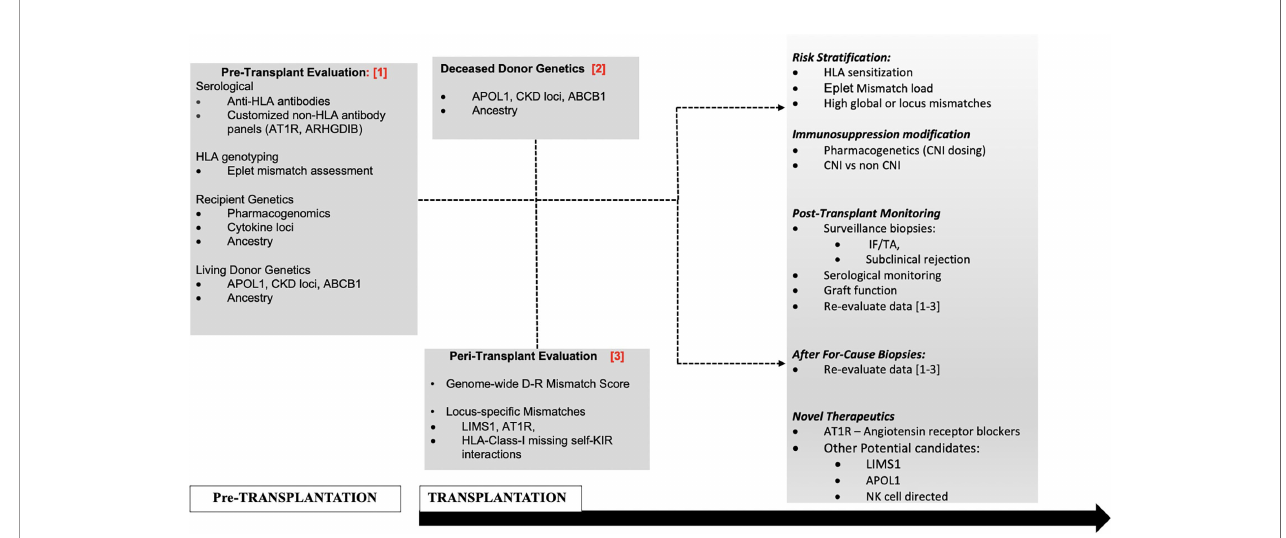
FIGURE 1 | Proposed management schema to incorporate non-HLA genetic assessments in D –